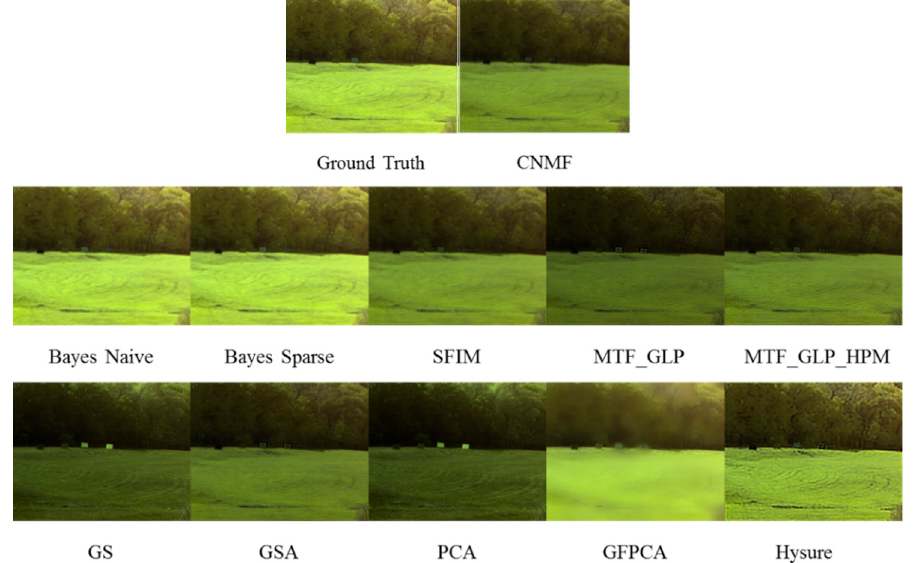
Figure 4. Fused AF images using different methods in the visible near infrared (VNIR) range.